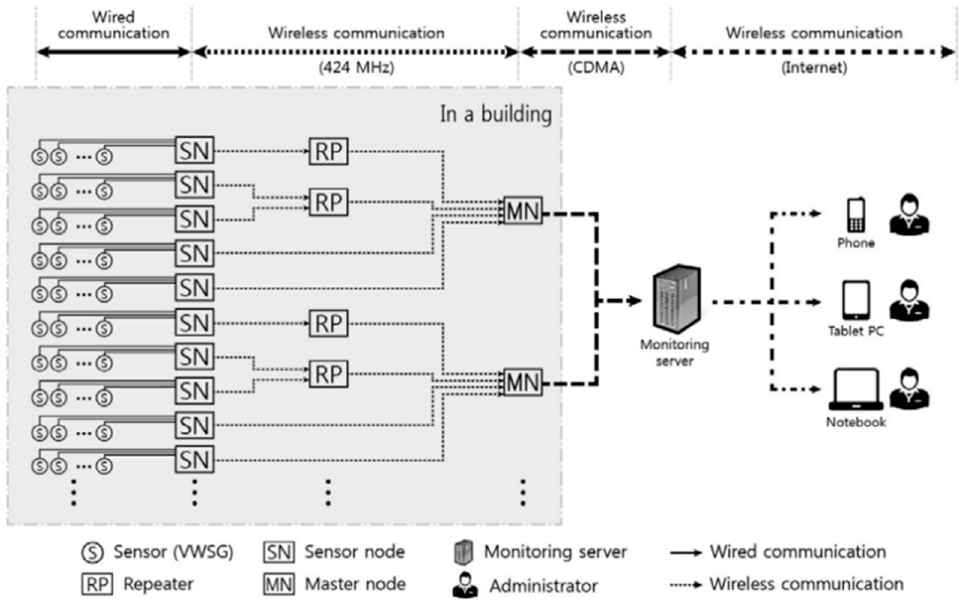
Figure 8. Wireless sensor network system for measurement of column shortenings in a high-rise building.